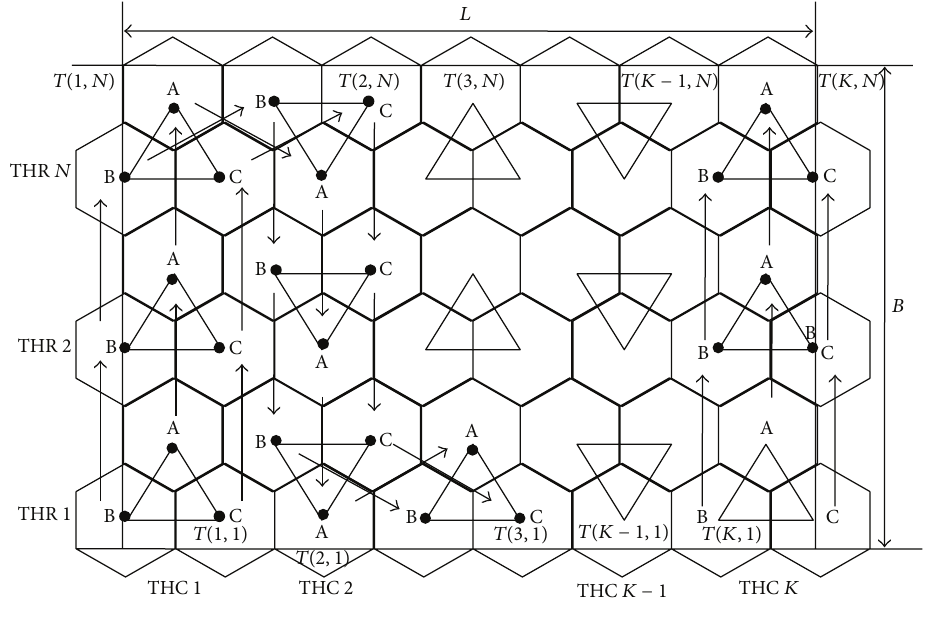
Figure 2: Triangle based MSNs traversal pattern.